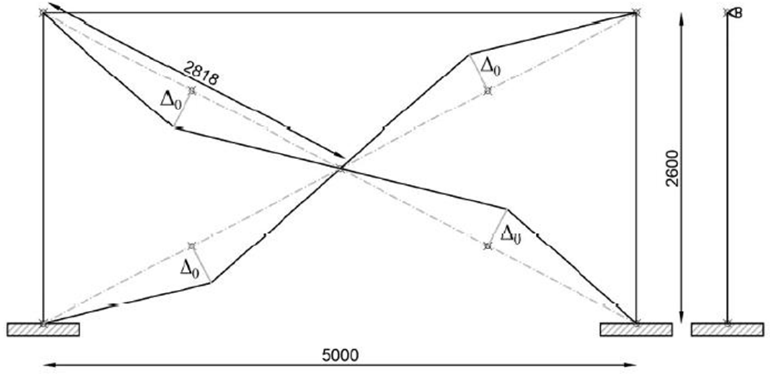
Figure 8. Representation of the initial imperfections (measurements in mm). The semi-diagonals were divided into eight equal elements and beams and columns into four (Figure 9). Fiber plastic hinges were then assigned to each element by considering their entire length.